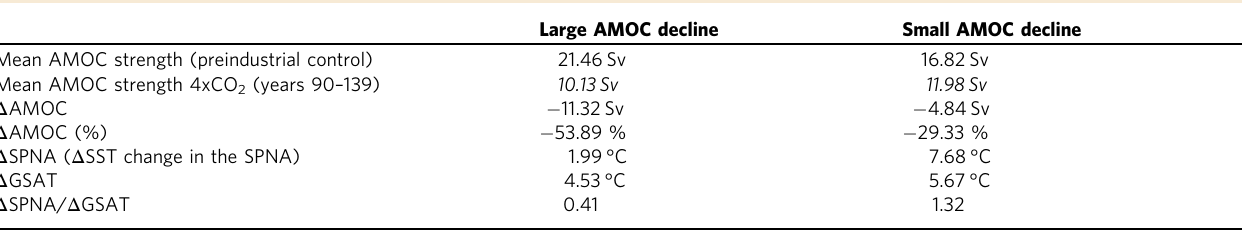
Fig. 1 Inter-model differences in the AMOC response. Panels a , b show the annual mean AMOC anomalies in the abrupt-4xCO 2 simulations at 26.5 °N for a CMIP5 and b CMIP6 models with respect to the mean AMOC strength computed from the preindustrial control. A 10-year running average smoothing has been applied to all curves for better visualization. Solid lines represent the models in the small AMOC decline group, while thick dashed lines represent the models in the large AMOC decline group. Models that do not belong to any groups, are represented by thin dashed lines. Panels c , d show transects of the ocean overturning stream-function in the North Atlantic for c the average of the large AMOC decline group, and d the average of the small AMOC decline group. Superimposed contours show the climatology computed from the preindustrial control of c the ten large AMOC decline models and d the 10 small AMOC decline models. Table 1 Differences in average values between the large and small AMOC decline